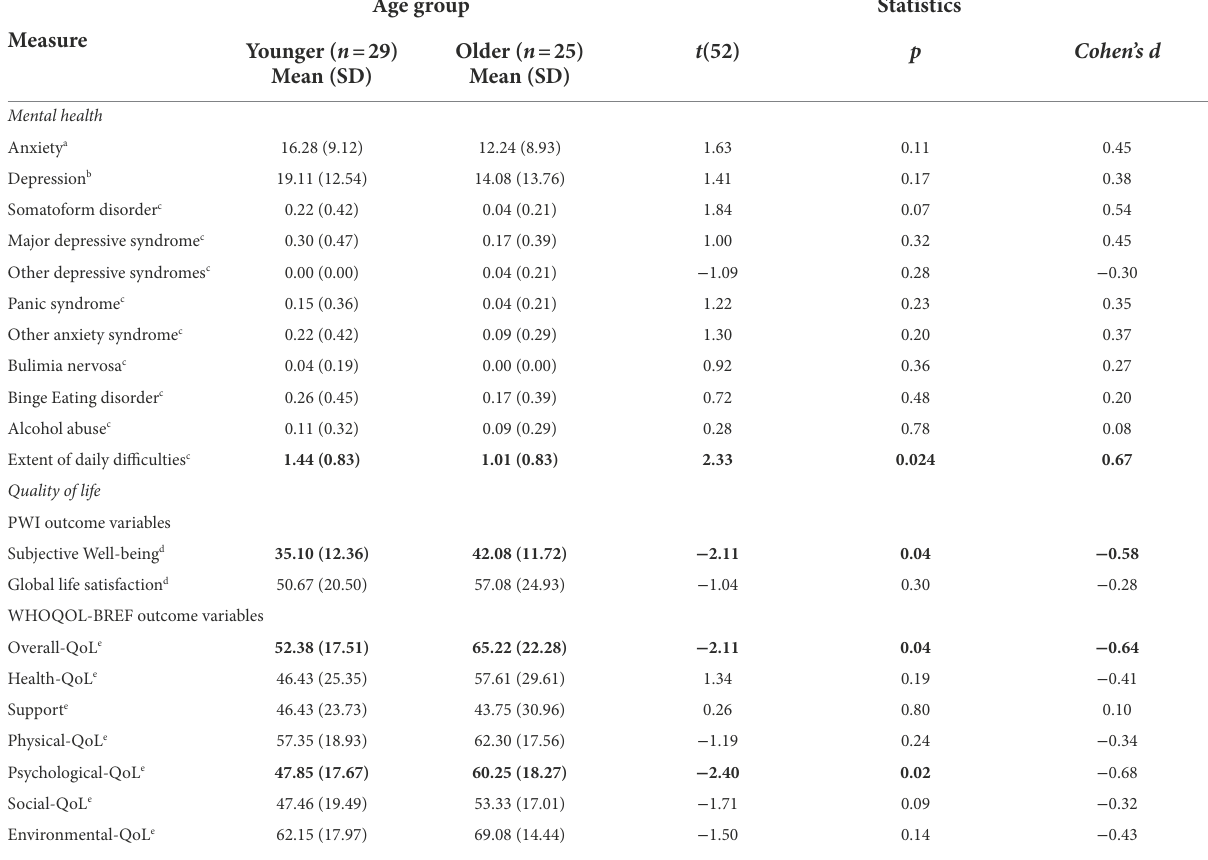
TABLE 5 T1 comparisons of mental health and QoL in younger and older